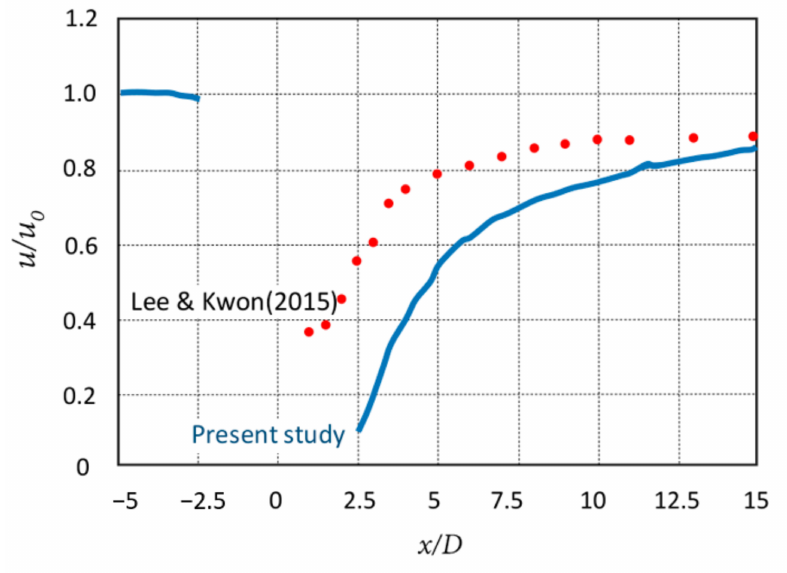
Figure 3. Normalized stream-wise wind velocity at hub height.